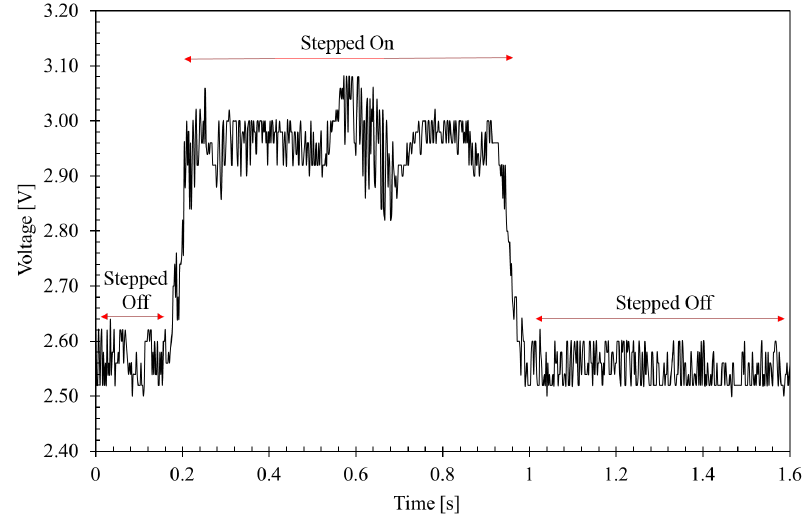
Figure 3. Output from an optical fibre in-ground pressure switch showing an increase of approximately 0.5 V when stepped